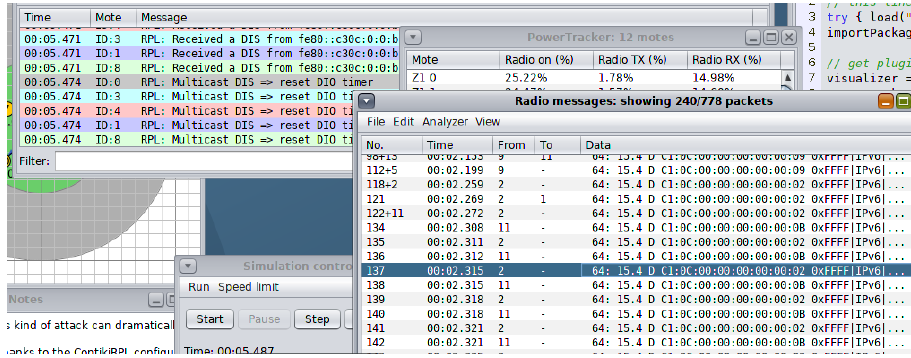
Figure 3. Cooja network simulator used to compute the performance metrics.